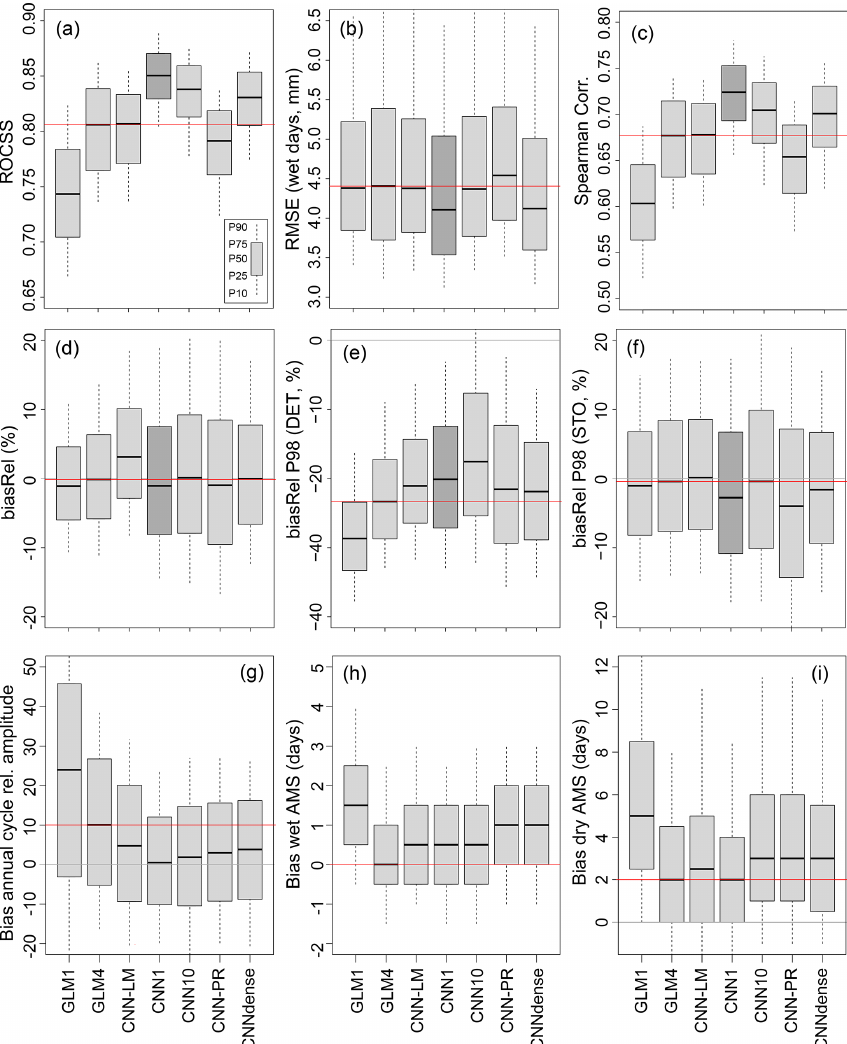
Figure 7. As in Fig. 4 but for precipitation. For the relative bias of the P98 the labels “DET” and “STO” refer to deterministic and stochastic,